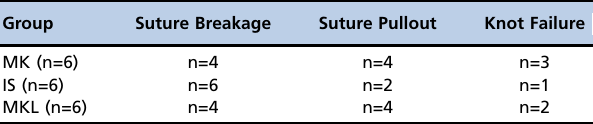
Figure 3 - Ultimate failure loads and 2-mm gap loads for different suture techniques. Compared with the MK technique, the IS and MKL techniques resulted in significantly greater 2-mm gap loads and ultimate failure loads. Error bars represent the SD from five porcine flexor tendons. * p o 0.05 vs . MK. Table 4 - Failure modes for three suture techniques.